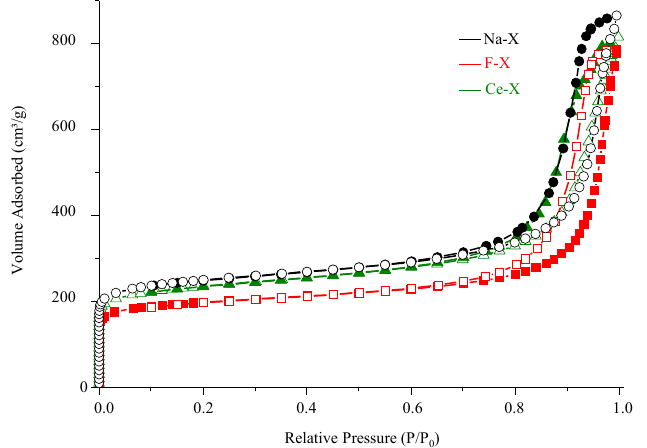
Figure 4. N 2 adsorption (full symbols) and desorption (empty symbols) isotherms of as-synthesized Na-X (black circle), fluorinated F-X (red square), and cerium ion exchanged Ce-X (green triangle) zeolites. Table 1. BET-specific surface area (S BET ), micropore volume (V mic ) and total pore volume (V total ) of as synthesized Na-X, fluorinated F-X, and ion exchanged Ce-X zeolites.